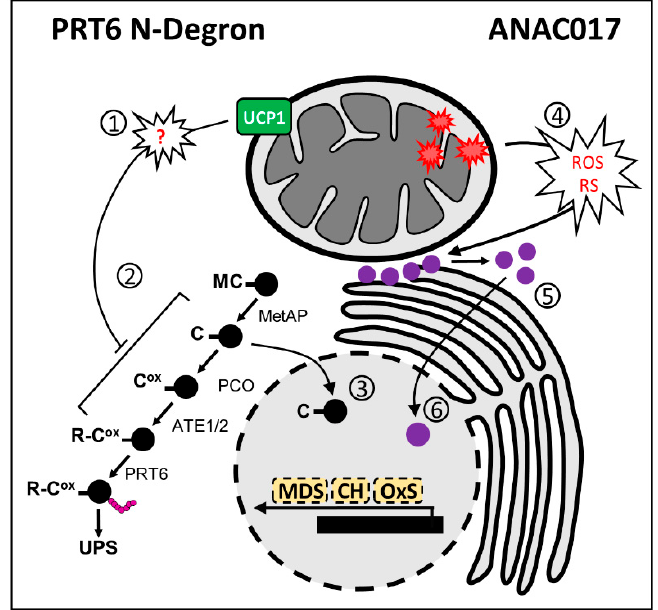
Figure 4. Mechanisms of retrograde signaling in response to alterations of mitochondrial function. Left panel (PRT6 N-Degron signaling) : (1) Disturbances of mitochondrial homeostasis by altered UNCOUPLING PROTEIN 1 (UCP1) expression induce the production of yet unknown signals that alter the stability of PRT6 N-Degron substrates. (2) Schematic representation of PROTEOLYSIS 6 (PRT6) N-Degron (Gibbs et al., 2011 [78]). (3) Increased UCP1 activity alters nuclear gene expression via stabilization of the GROUP VII ETHYLENE RESPONSIVE TRANSCRIPTION FACTORS (ERFVIIs). Stable ERFVIIs in the nucleus can induce core-hypoxia (CH) [78] and oxidative stress-related genes (OXs) [77]. A few components of the mitochondrial dysfunction stimulon (MDS) were found to be differentially expressed in lines with altered PRT6 N-Degron depending on the growth stage [77,78]. Black circles indicate protein substrates (ERFVIIs), amino-terminal amino acids are single letter codes, and ox indicates oxidized cysteine. MetAP, METHIONINE AMINO-PEPTIDASE; ATE, ARGINYL TRANSFERASE. Right panel (ANAC017 signaling) : (4) Inhibition of mitochondrial respiration at Complex III (using antimycin A) leads to (5) protease cleavage of ANAC017, releasing an amino-terminal (Nt-) fragment that (6) relocates from the endoplasmic reticulum (ER) membrane to the nucleus to activate the expression of MDS components. Reactive oxygen species (ROS) and reductive stress (RS) have been proposed as signals that can mediate ANAC017 release from the ER. In addition to MDS, ANAC017 regulates CH and OxS genes [92,94]. Purple circles indicate the ANAC017 protein, either full-length at the ER or cleaved N-terminal fragment, as soluble and nuclear.